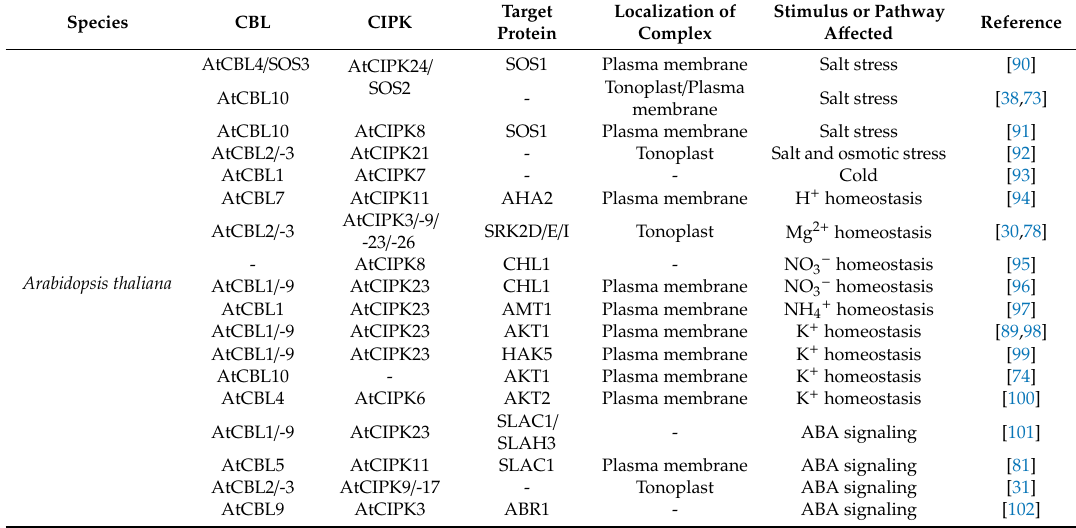
Table 2. Overview of CBL–CIPK modules in